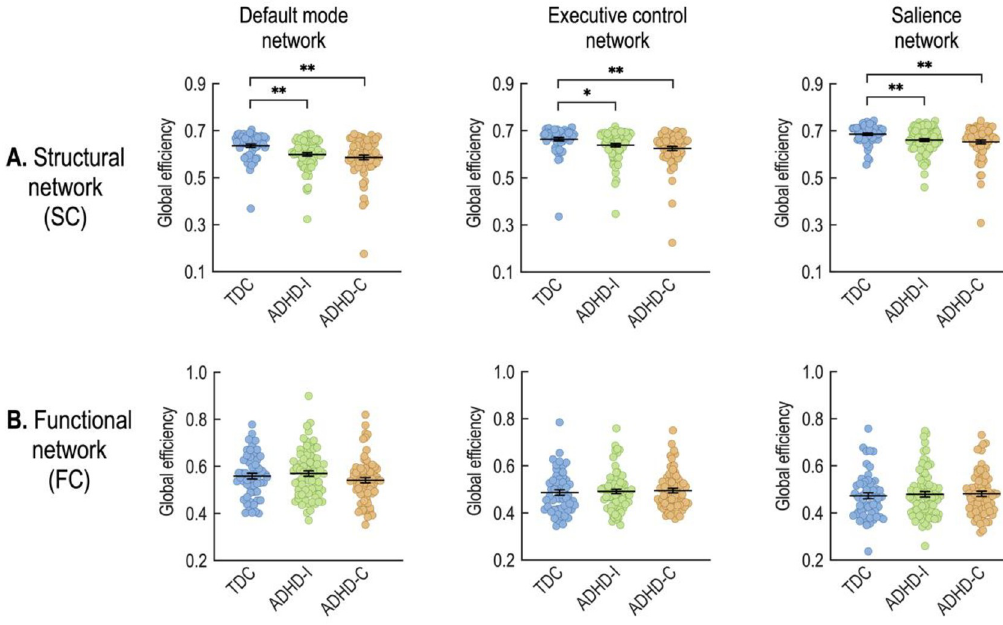
Fig 3. Group comparisons of global structural efficiency (A) and global functional efficiency (B) in the default mode, executive control, and salience networks. � p < 0.05, �� p < 0.01 (two-sample t-tests).